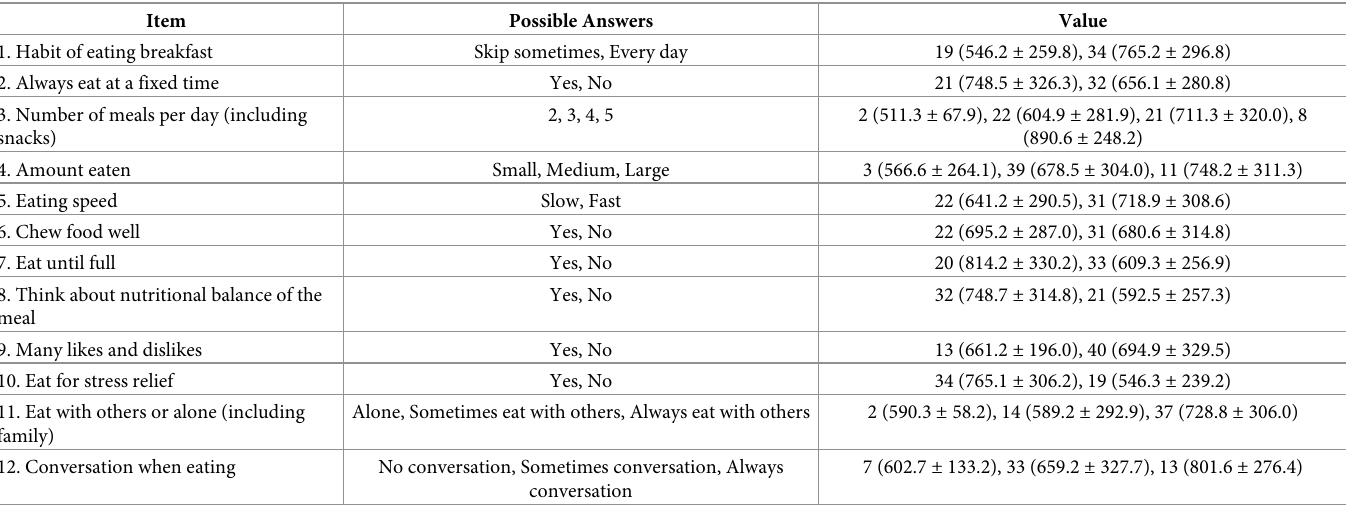
Table 2. Questionnaire items and answers.